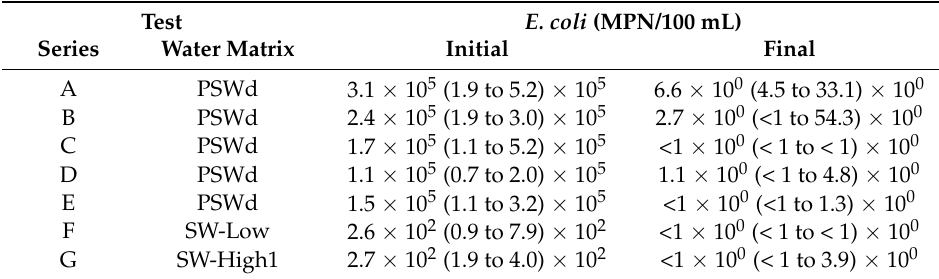
Table 2. Summary of the AQS treatment performance trials mean microbiological results (with 95% confidence intervals) for initial (untreated) and final (after Coagulant/disinfection product (CDP) treatment—60 min for all test conditions except “cold temperature” series D in which treatment time totaled 20 min)